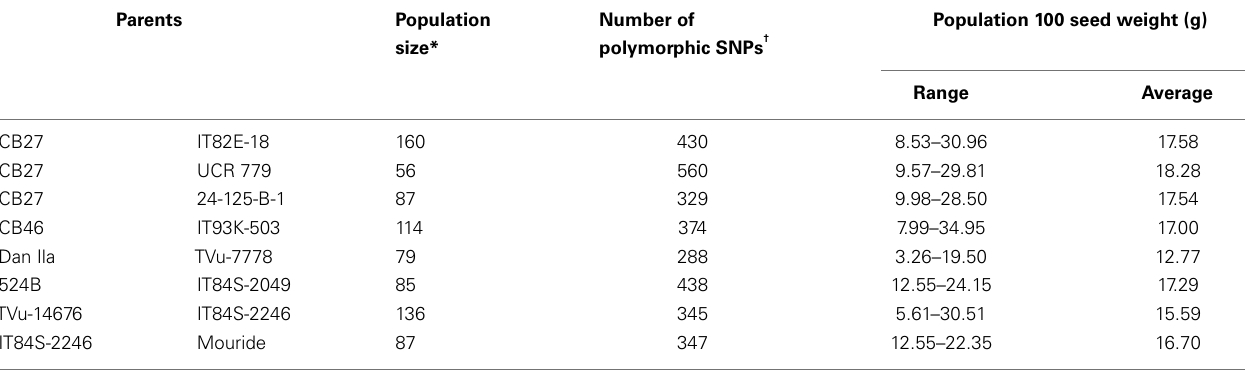
Table 1 | Characteristics of eight bi-parental populations of cowpea used to associate loci with seed